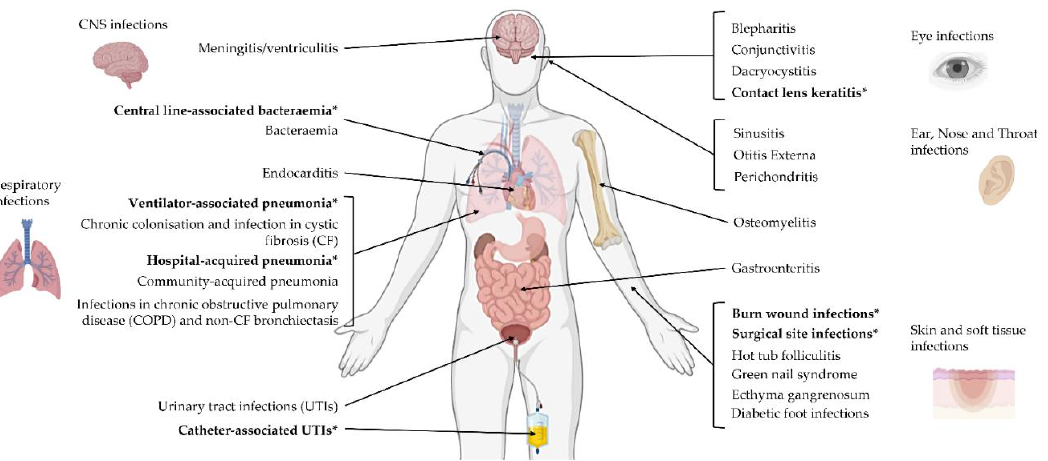
Figure 2. The many sites of P. aeruginosa infection throughout the body. Labels in bold and starred (*) are those infections associated with healthcare or healthcare devices.